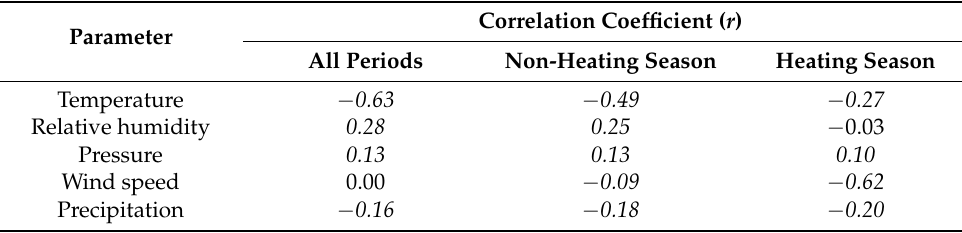
Table 3. The results of the Spearman correlation analysis between concentrations of eBC and selected meteorological parameters in 2015–2020. Correlation Coefficient ( r ) Parameter All Periods Non-Heating Season Heating Season